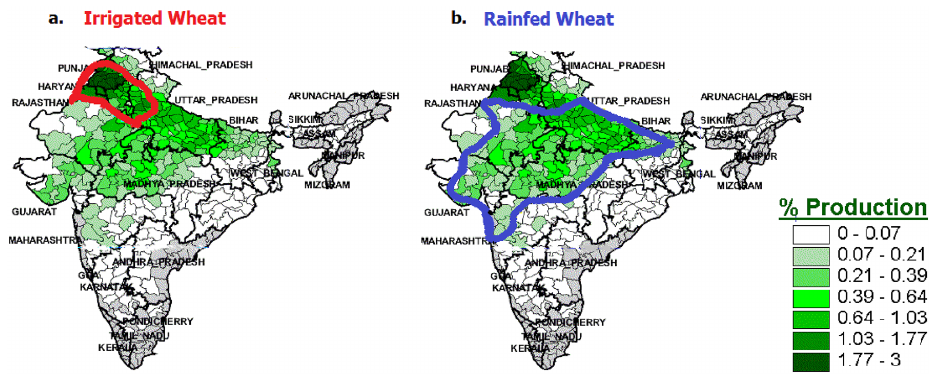
Figure 13. Map (a) shows the irrigated wheat growing areas of India. Map (b) shows the rain-fed wheat growing areas. Based on the location of our study area as shown in Fig. 1, most of the wheat grown in the UG Basin is rain-fed. Source: USDA-II (2013).